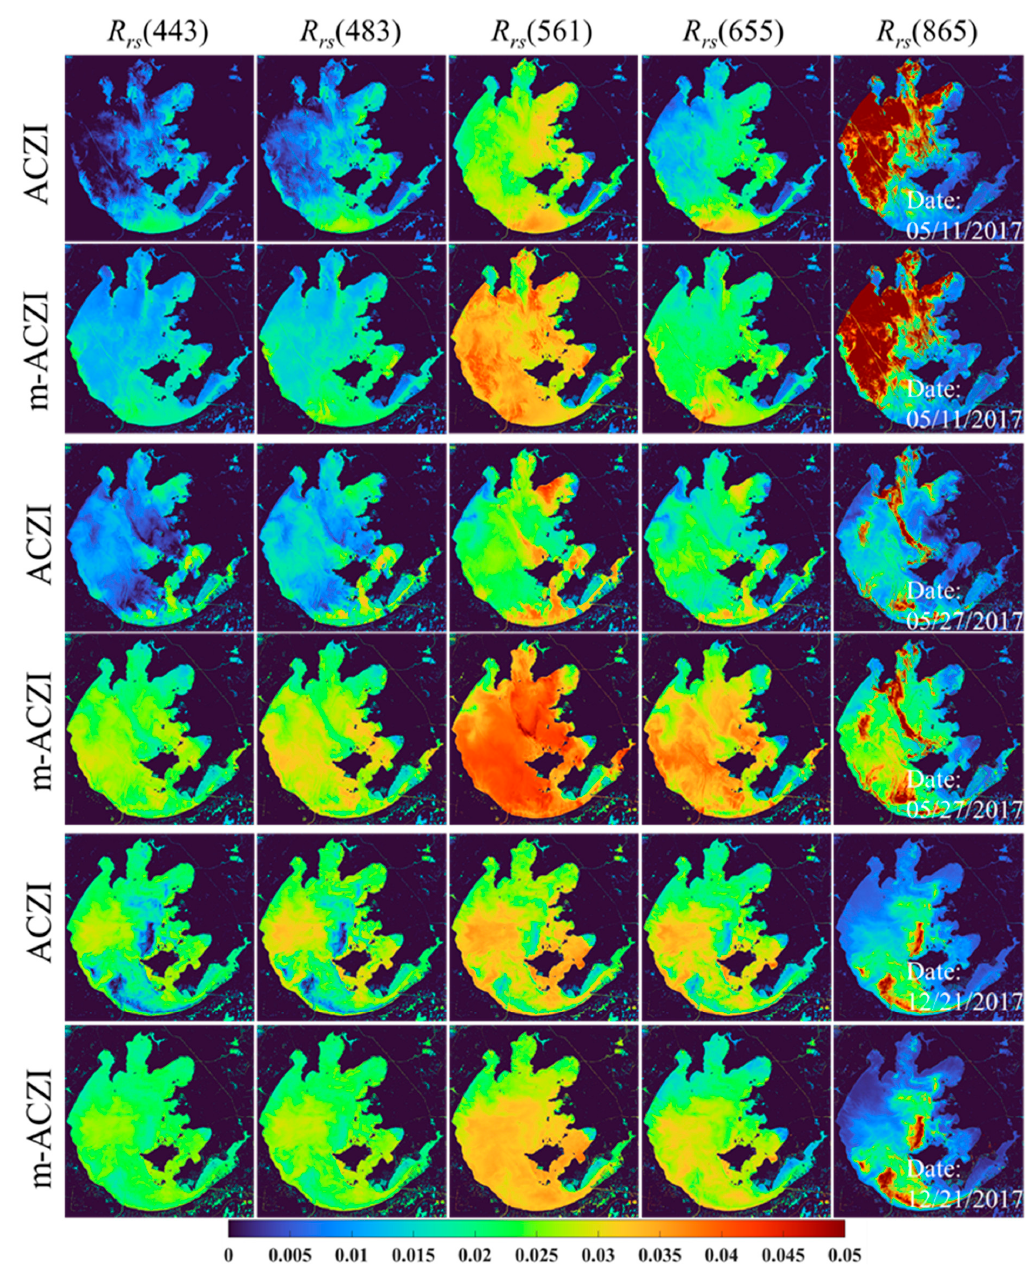
Figure 7. Comparison of the ACZI and the m-ACZI algorithms for OLI R rs over Lake Taihu